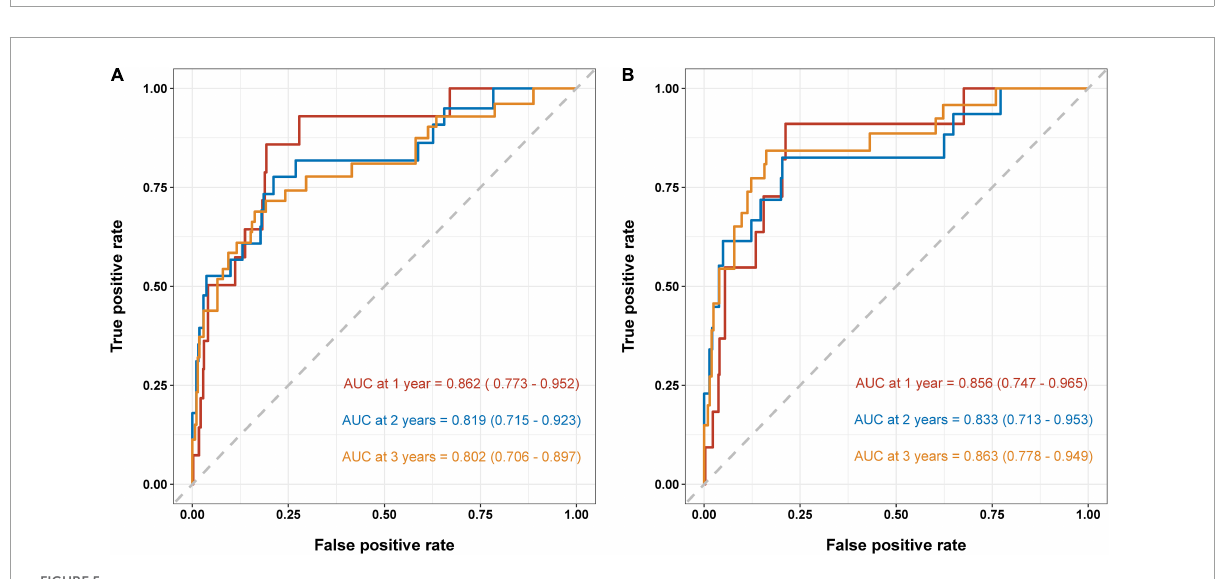
FIGURE5 Area under the ROC curves (AUC) for survival prediction in the overall population (A) and validation cohort (B) . ROC, receiver operator